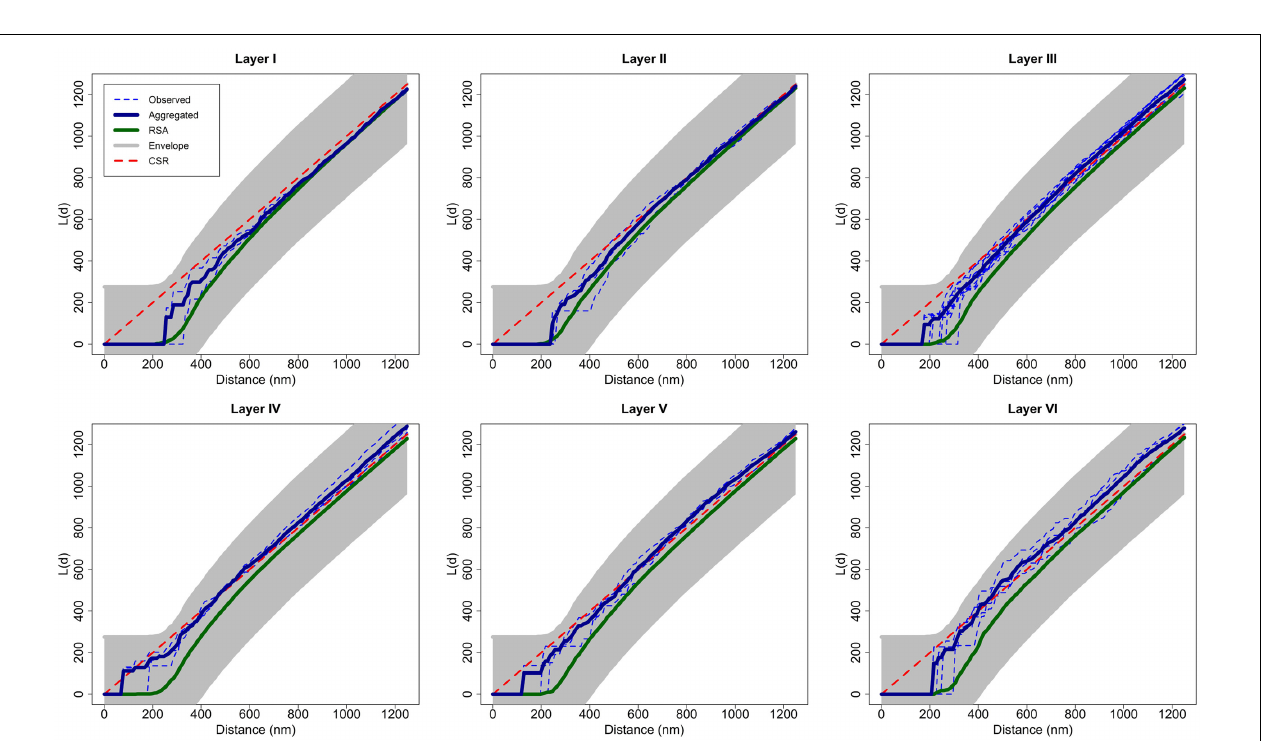
FIGURE 7 | For each layer, aggregated L function (dark blue) of experimentally observed data (dashed blue) along with the average of 99 RSA simulations (green) fitting the model for all samples of the layer. This figure shows the envelope obtained using a separate set of 99 RSA